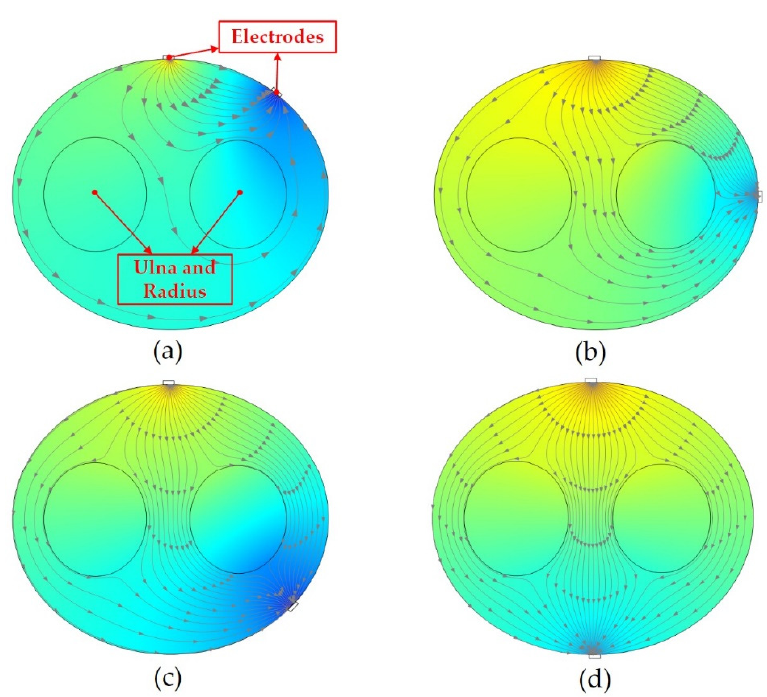
Figure 11. Simulation analysis of different excitation measurement patterns. The big ellipse represents the cross-section of our arm. The two small ellipses are the ulna and radius inside the arm, and the gap represents the arm muscle.